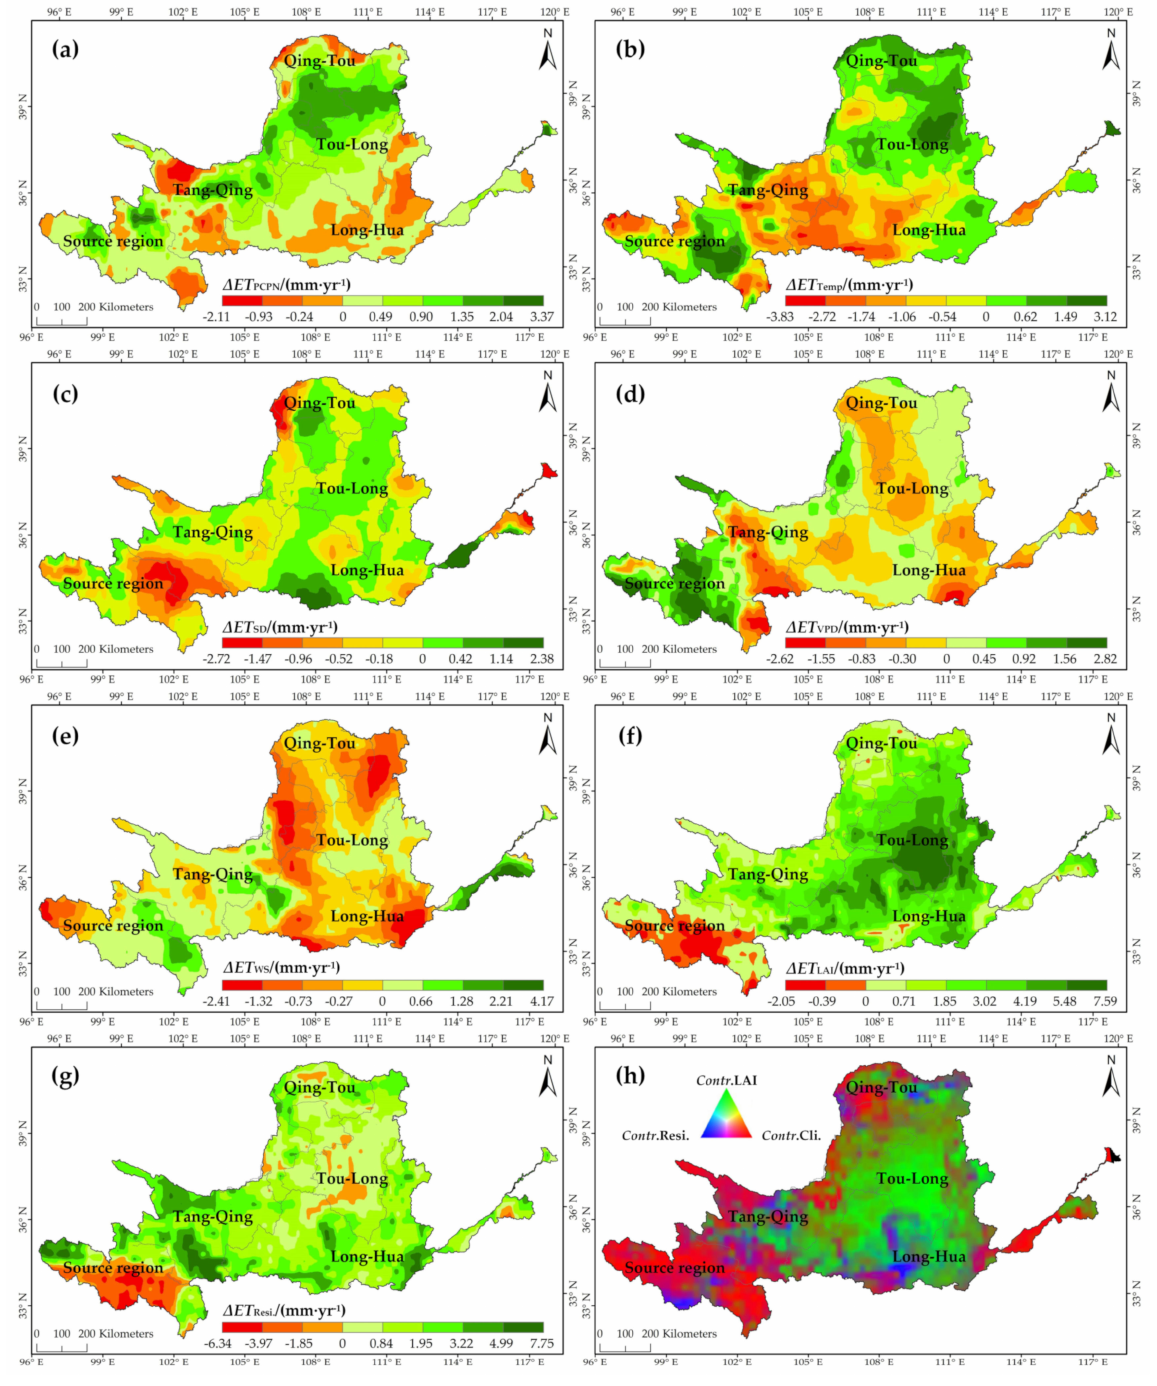
Figure 8. Spatial distributions of the impacts of the climatic and vegetation factors on the ET trend: ( a ) impact of PCPN, ( b ) impact of Temp, ( c ) impact of SD, ( d ) impact of VPD, ( e ) impact of WS, ( f ) impact of LAI, ( g ) impact of the residual factors, and ( h ) a visual view of the relative impact rate of climatic factors, LAI and residual factors on the map produced using a Maxwell color